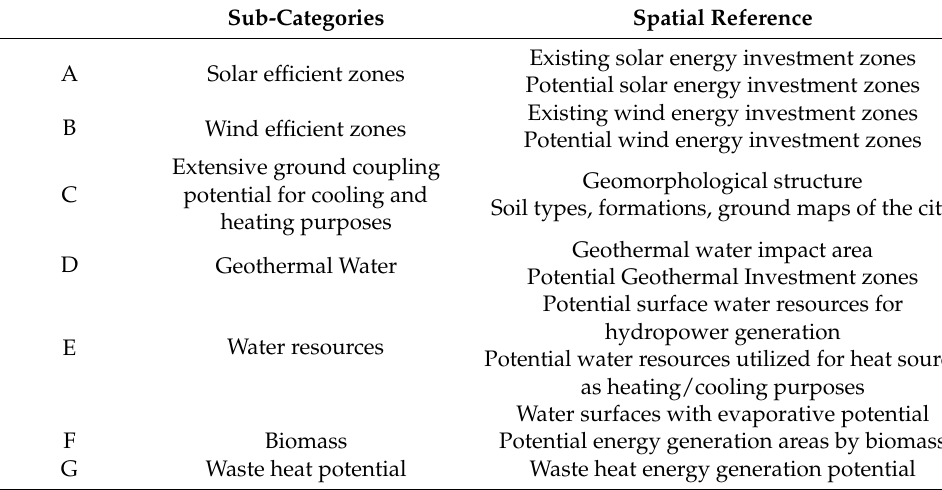
Table 1. Category 1: Resource availability.